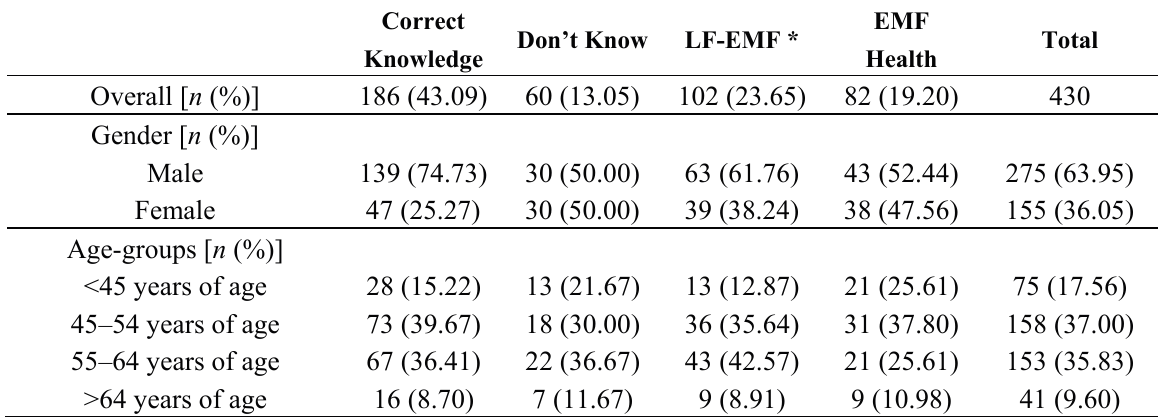
Table 4. Characteristics of GPs in each of the latent classes, GPs in Germany in